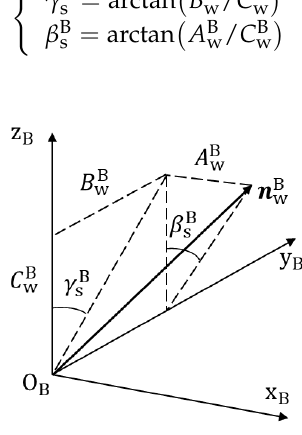
Figure 12. Illustration of 𝛾 𝑠B and 𝛽 𝑠B .